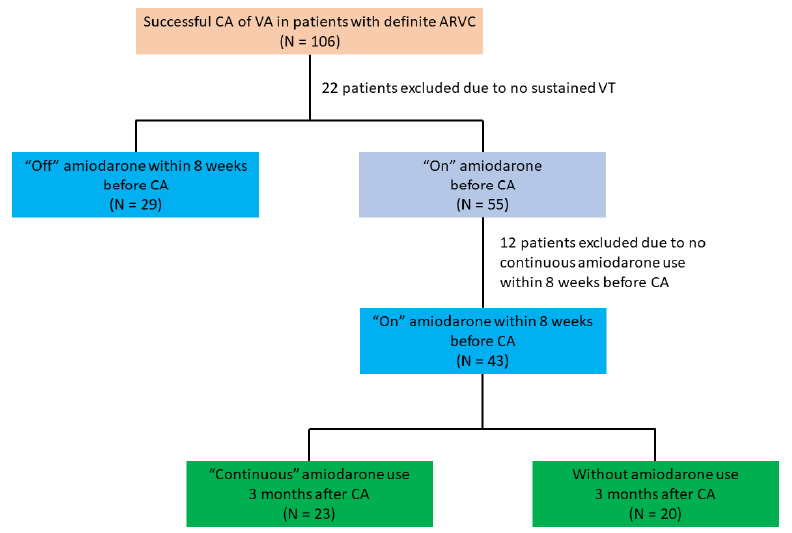
Figure 1. Patient selection in the present study. Patients with ARVC receiving successful CA for ven- tricular arrhythmia were screened. We enrolled ARVC patients with clinically documented sustained VT, and patients were further categorized into two groups based on their use of amiodarone within the 8 weeks before CA. ARVC = arrhythmogenic right ventricular cardiomyopathy; CA = catheter ablation; VT = ventricular tachycardia. Table 1 . Comparison of baseline characteristics between patients with ARVC “On” and “Off” amio- darone before CA.